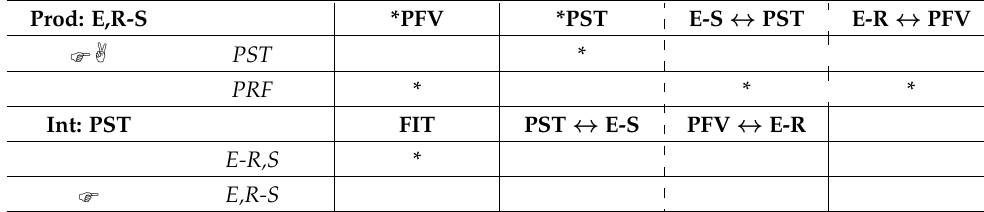
Tableau 2. Asymmetrical optimization in English and Spanish (example (12)). Tableau 5. Symmetrical optimization in English and Spanish (example (11)). Tableau 1. Bidirectional optimization of tenses.